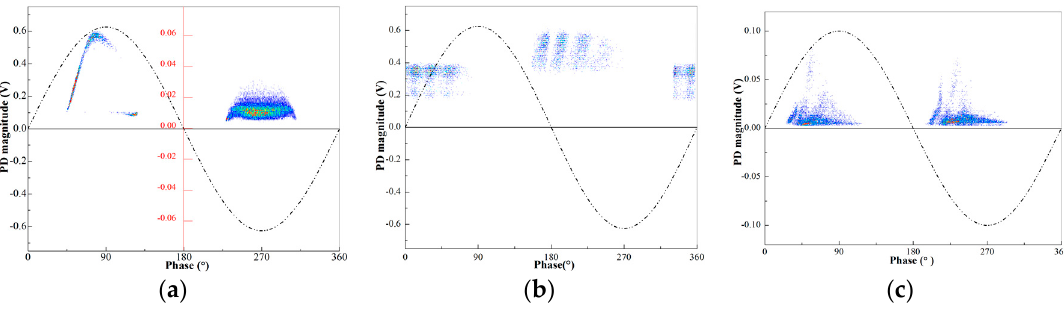
Figure 17. PRPD diagram of switchgear typical insulation defects: ( a ) needle-plate discharge caused by metal protrusion; ( b ) floating potential discharge caused by bad electrical contacts; and ( c ) surface discharge due to pollution of the insulator or metal particle on the insulator surface.